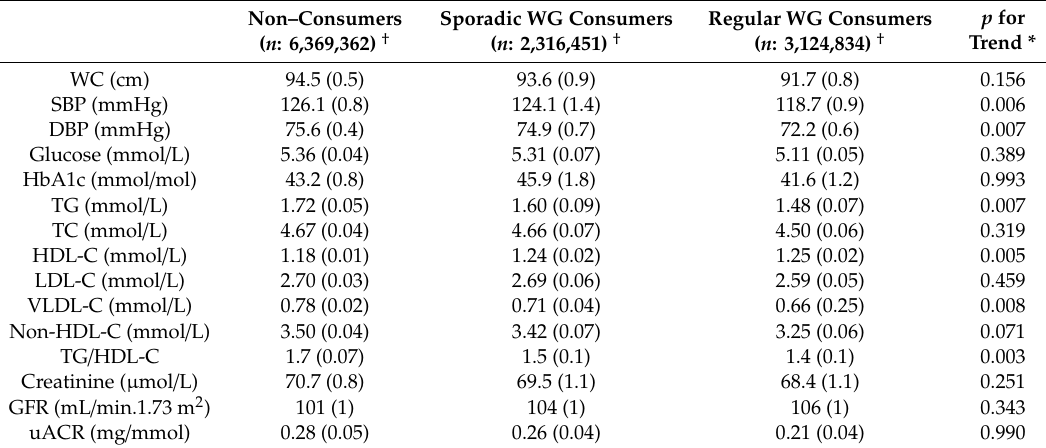
Table 2. Risk factors for cardiorenal metabolic diseases according to the frequency of WG